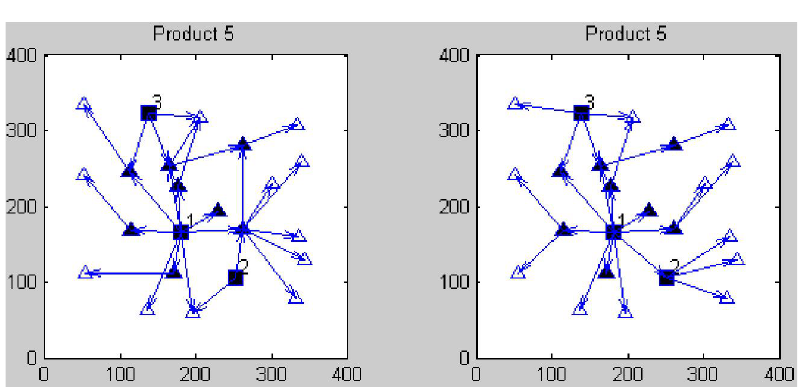
Fig. 9. Transshipment paths (product